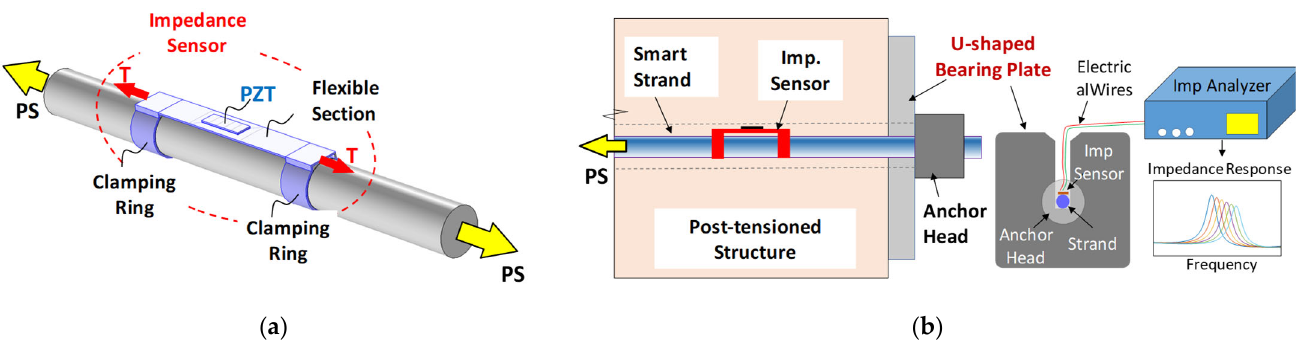
Figure 1. Overview of the smart strand technique for post-tensioned structures. ( a ) Smart strand concept; ( b ) Measurement system.